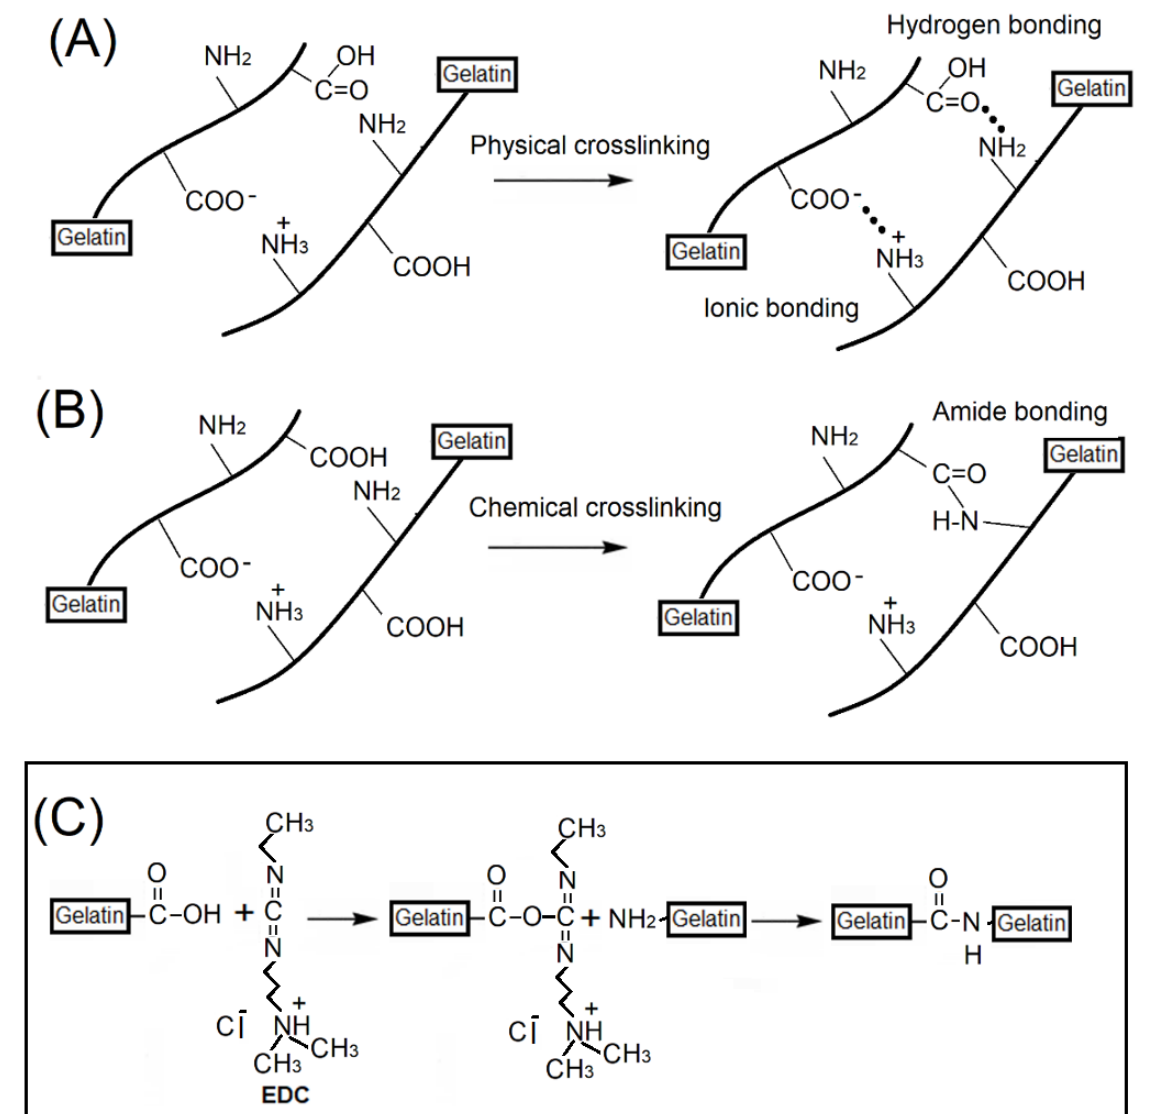
Figure 3. Schematic representing the possible interactions within gelatin molecules, formation of hydrogen bonds during swelling and amide bonds via ( A ) physical and ( B ) chemical crosslinking behaviors, in which a crosslinking agent of EDC would be used ( C ).